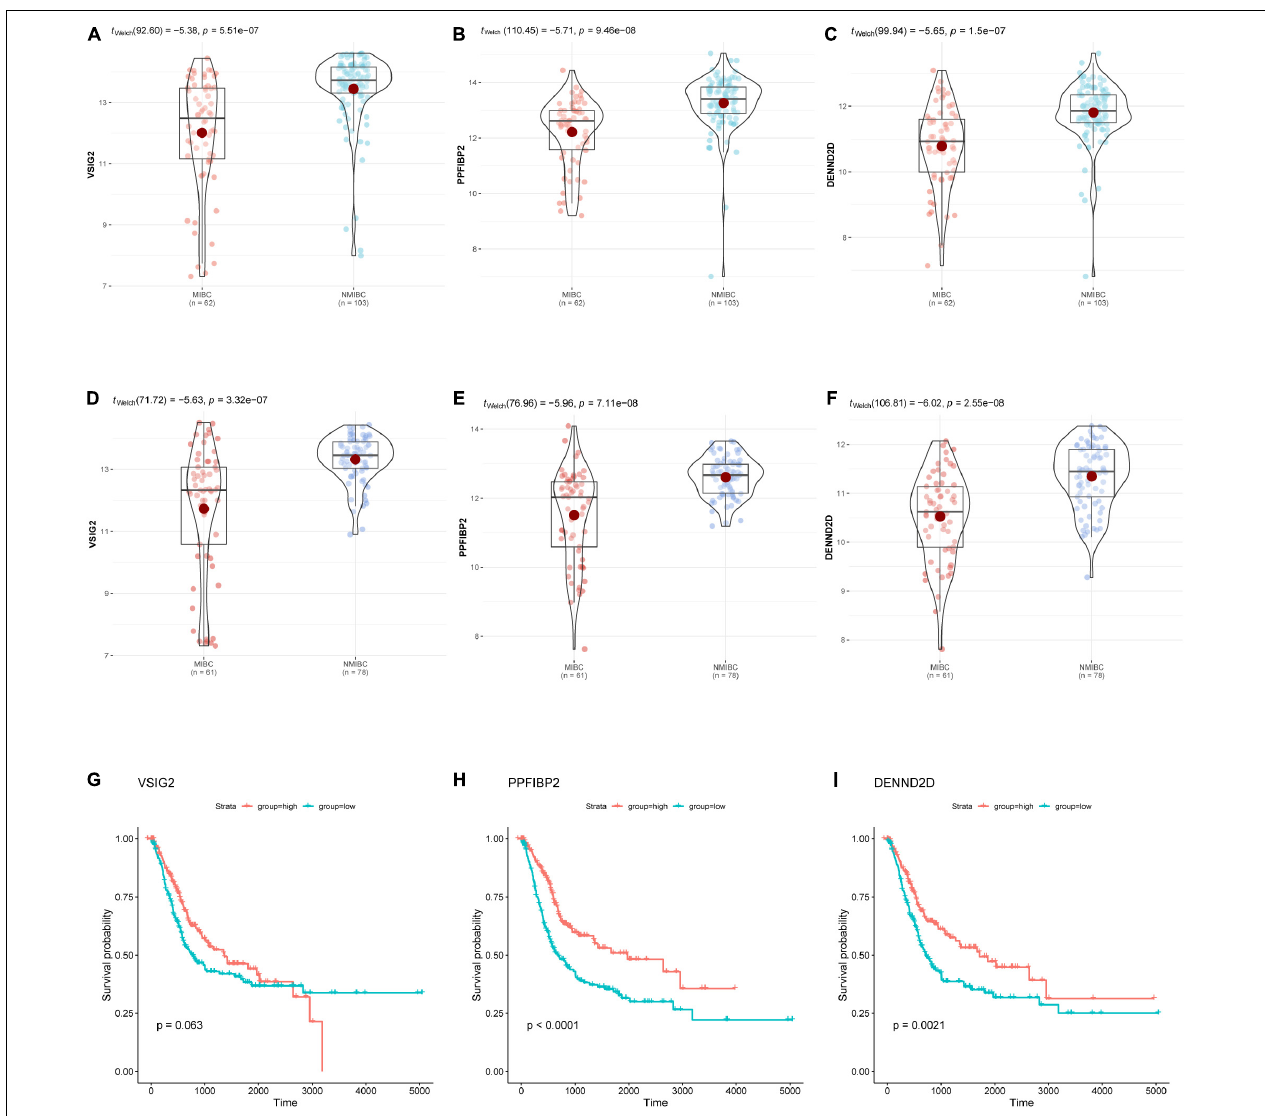
FIGURE 6 | The expression of hub genes ( VSIG2 , PPFIBP2 , and DENND2D ) in the GSE13507 dataset (A–C) and the GSE120736 dataset (D–F) . Kaplan-Meier survival curves for patients with different expression levels of hub genes (G–I) . The expression levels of groups were classified according to the median gene expression